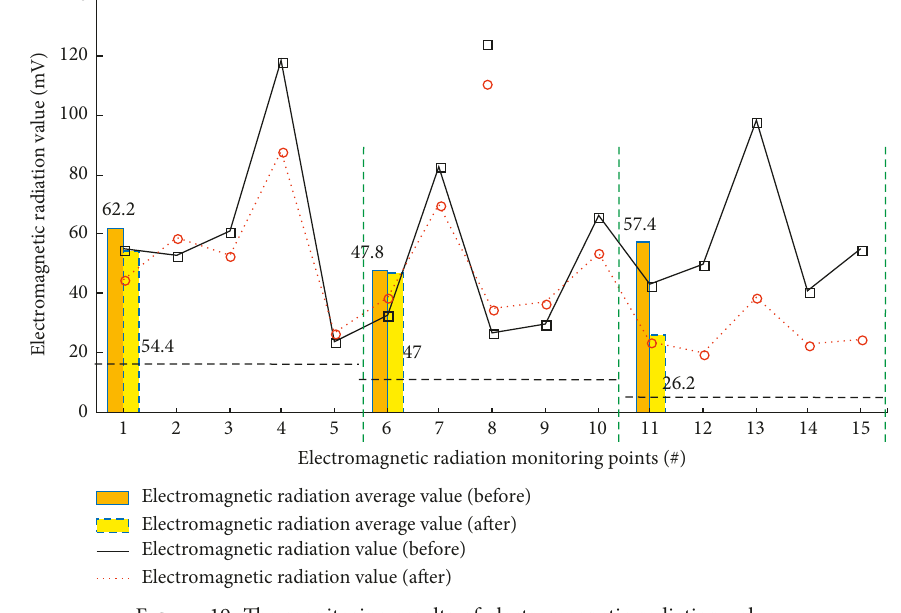
Figure 19: The monitoring results of electromagnetic radiation value.